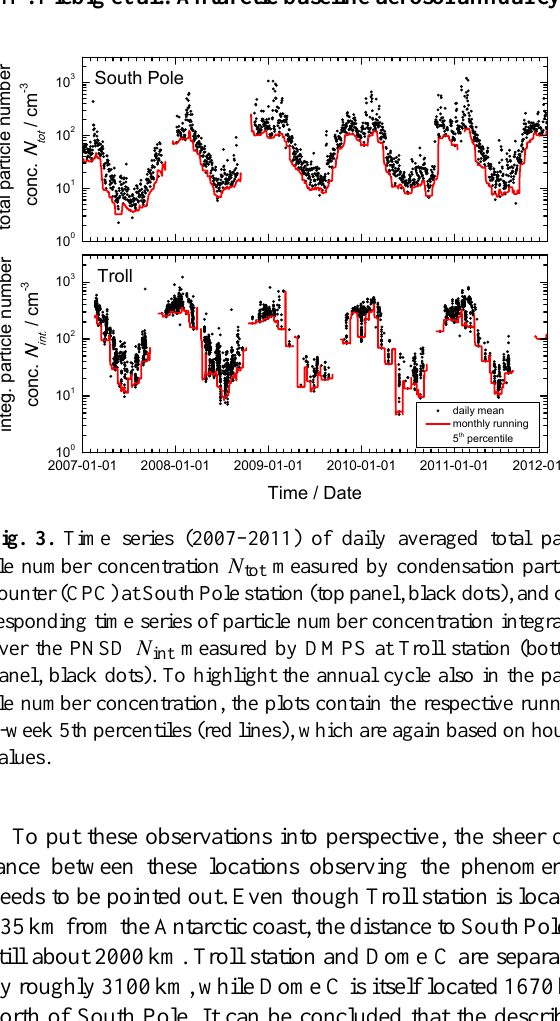
Fig. 4. Scatter plot of the aerosol scattering coefficient measured directly by integrating nephelometer (x-axis), and calculated from the particle number size distribution assuming non-absorbing, spherical particles consist- ing of ammonium sulphate, one panel for each of the nephelometer wavelengths. Also plotted are the linear regressionlines(redsolid, interceptfixedat0),includingtheirslope m andthecoefficient ofdetermination R 2 , as well as the 1:1 line (black dashed).